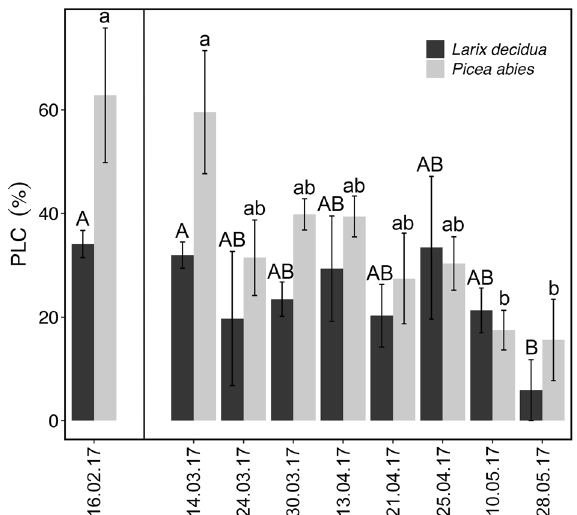
Figure 7. PLC measurements. Percent loss of conductivity (PLC, %) measured on branches of L. decidua (dark bars) and P. abies (gray bars) collected weekly during the seasonal course. Means ± SE. Different letters ( L. decidua : capital; P. abies : lower case) indicate significant differences ( P < 0.05) between means. The first PLC measurement (i.e., 16.02.2017) was done before the start of the labelling experiment.